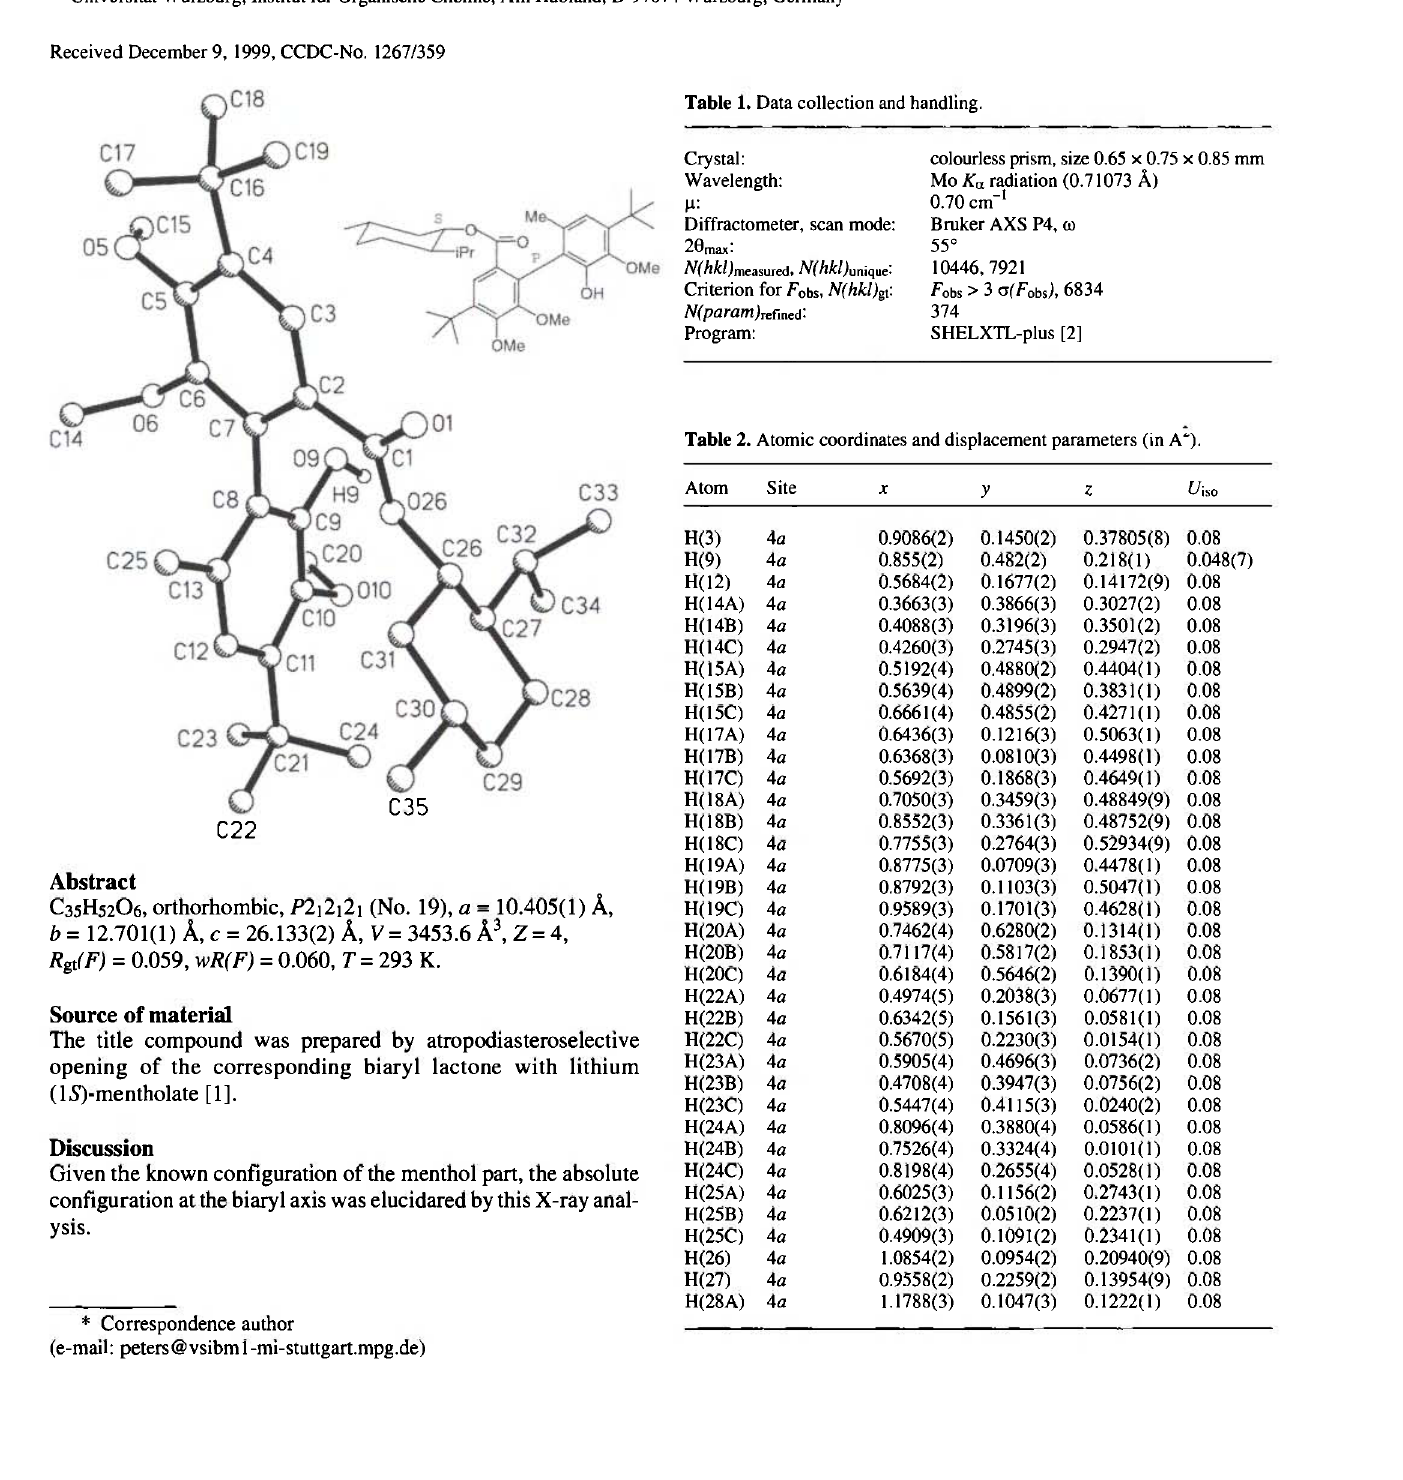
Table 1. Data collection and handling.